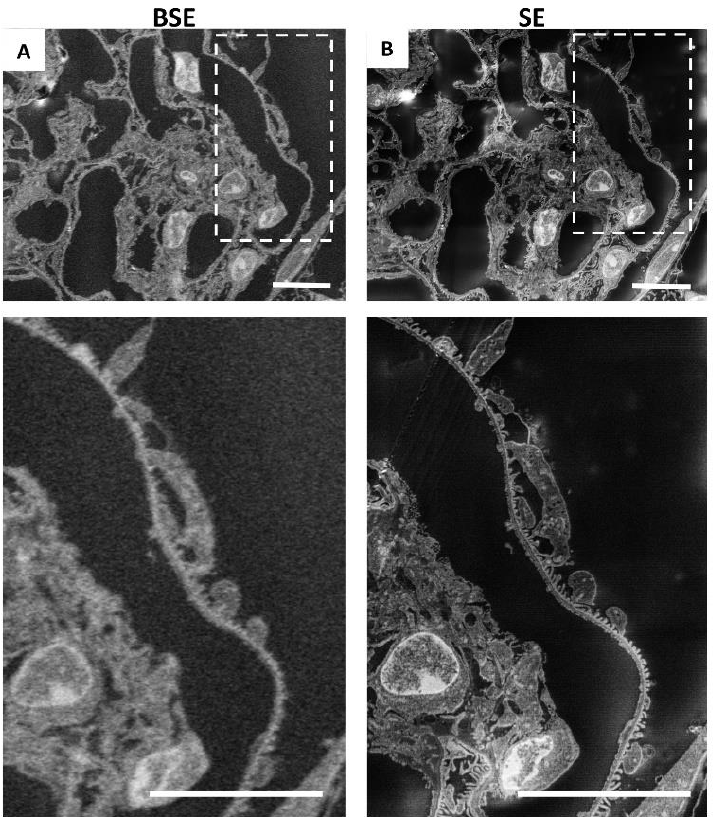
Figure 2. Resolution obtained by secondary electrons is higher than that achieved by backscattered electrons: ( A ) representative image of renal ultrastructure taken with SEM with backscattered electrons or ( B ) with secondary electrons. Insets (lower panels) show a high-power view of the same cells. Scale bars: 10 µm.